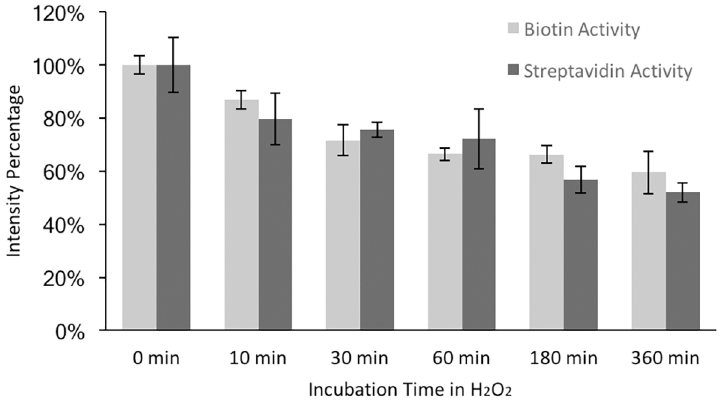
Fig 5. Biotin and streptavidin activity after H 2 O 2 incubation. Microarrays were fabricated and conjugated with biotin as per Method 2. Streptavidin conjugated chips were obtained by incubating biotin conjugated chips with 100ug/ml non-fluorescent streptavidin solution overnight. Both biotin and streptavidin conjugated chips were then incubated in 0.35% H 2 O 2 for 10min, 30min, 60min, 3h and 6h at room temperature. After H 2 O 2 incubation, all chips were blocked in 1%BSA. Biotin chips were then labeled with 10ug/ml Strep-647 while streptavidin chips were labeled with 1ug/ml Biotin-488. Intensity was normalized by using control group (0min) as 100% intensity.